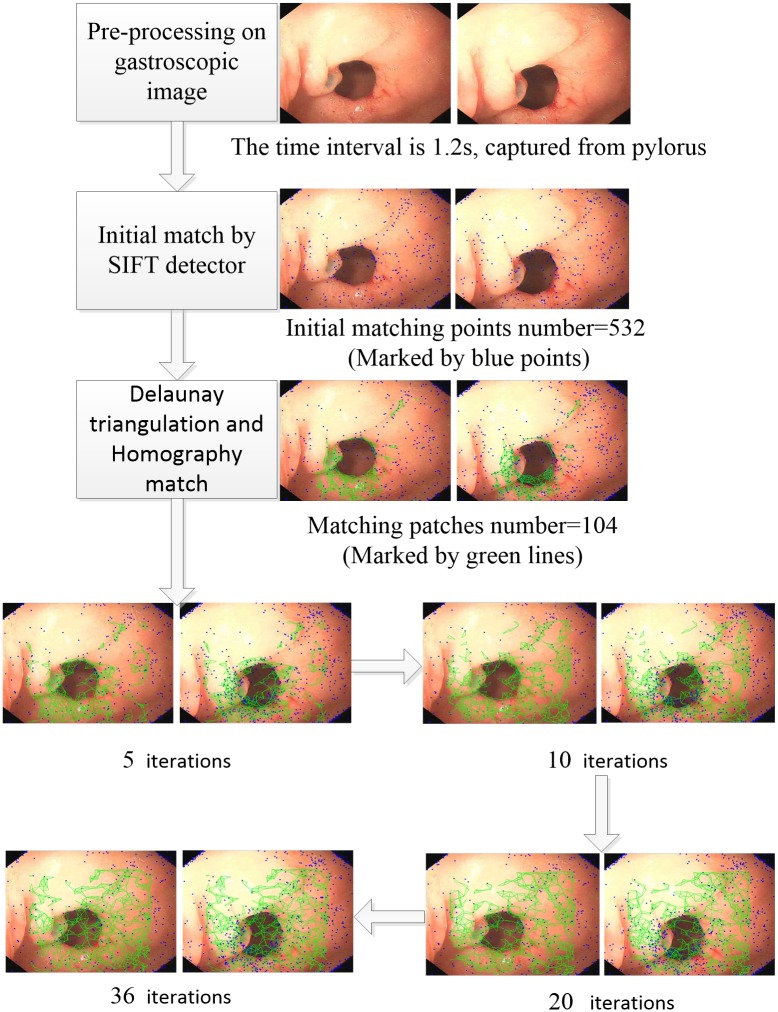
Workflow of the registration on the pylorus.HPFT finished after 36 iterations. The blue points indicate matching points, and the green triangles indicate matching patches.